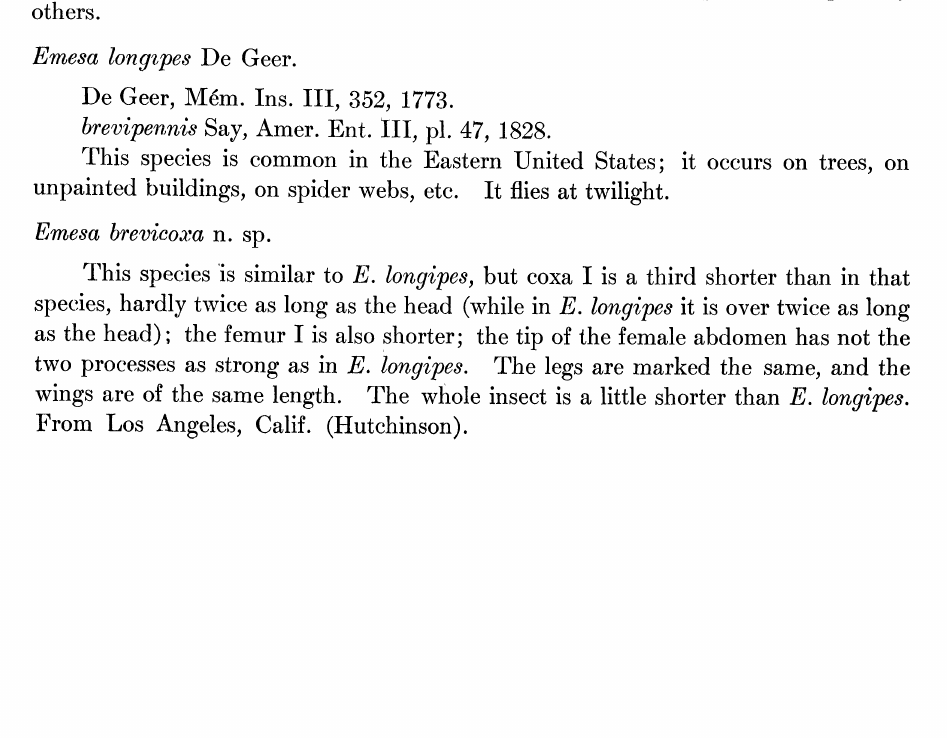
Barce Traterna, lust abdominul segment of mule und